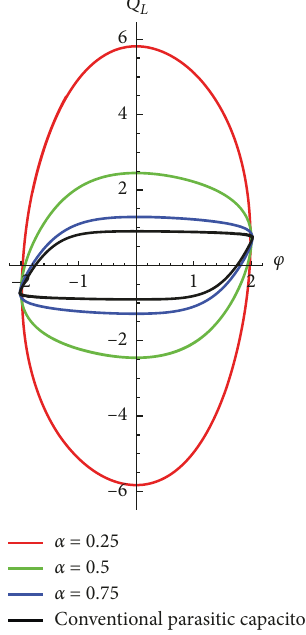
Figure 10: Q L vs φ of the memristor-inductor circuit with the parasitic fractional capacitor/conventional parasitic ca- pacitor [9].